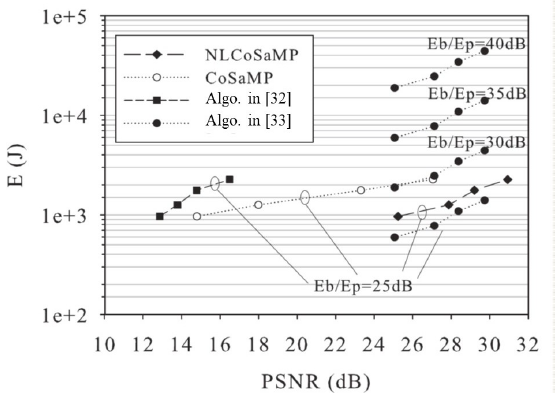
Figure 8. Energy E ( J ) vs. PSNR for in-network CS reconstruction algorithms (NLCoSaMP, CoSaMP, and [32]) and off-network one